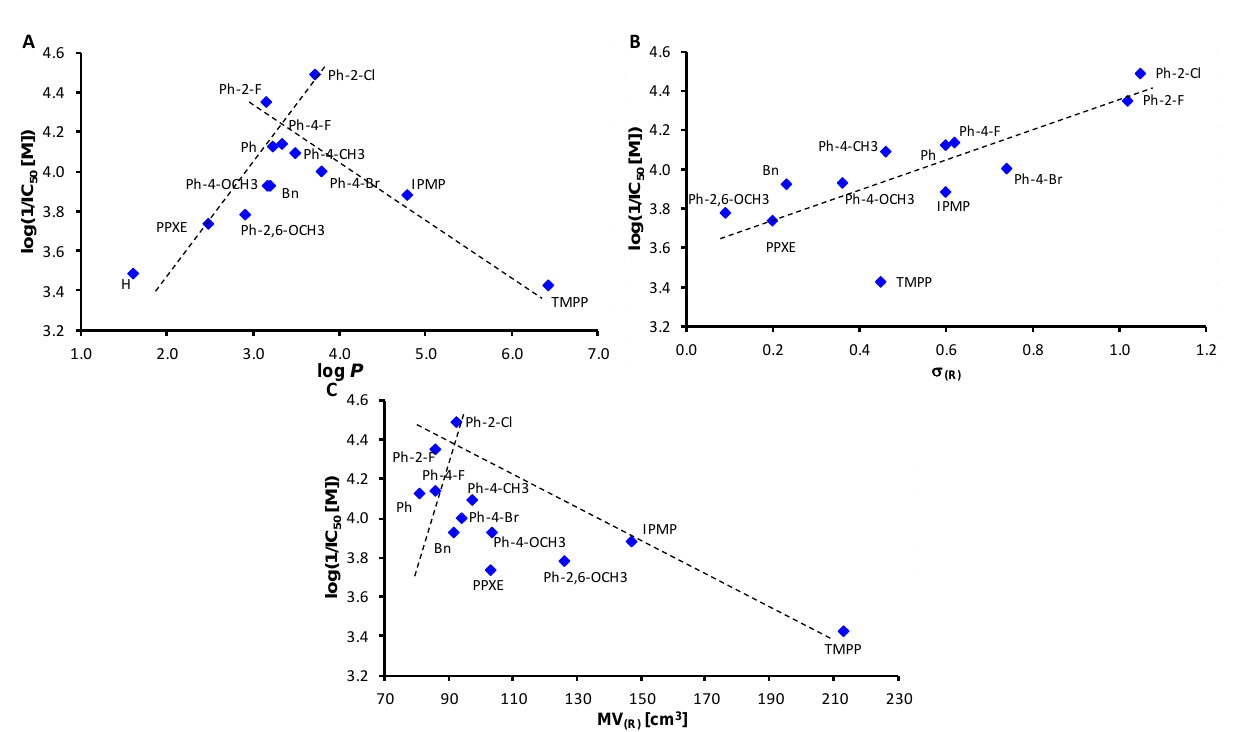
Figure 3. Dependences of BChE-inhibiting activity log(1/IC 50 (M)) of all compounds 1 – 13 on lipophilicity expressed as log P ( A ), electronic σ parameters and bulkiness expressed as molar volume (MV) of whole O -part of individual esters ( B , C ). IPMP = 2-isopropyl-5-methylphenyl, TMPP = 4-(2,4,4-trimethylpentan-2-yl)phenyl, PPXE = 2-propoxyethyl.